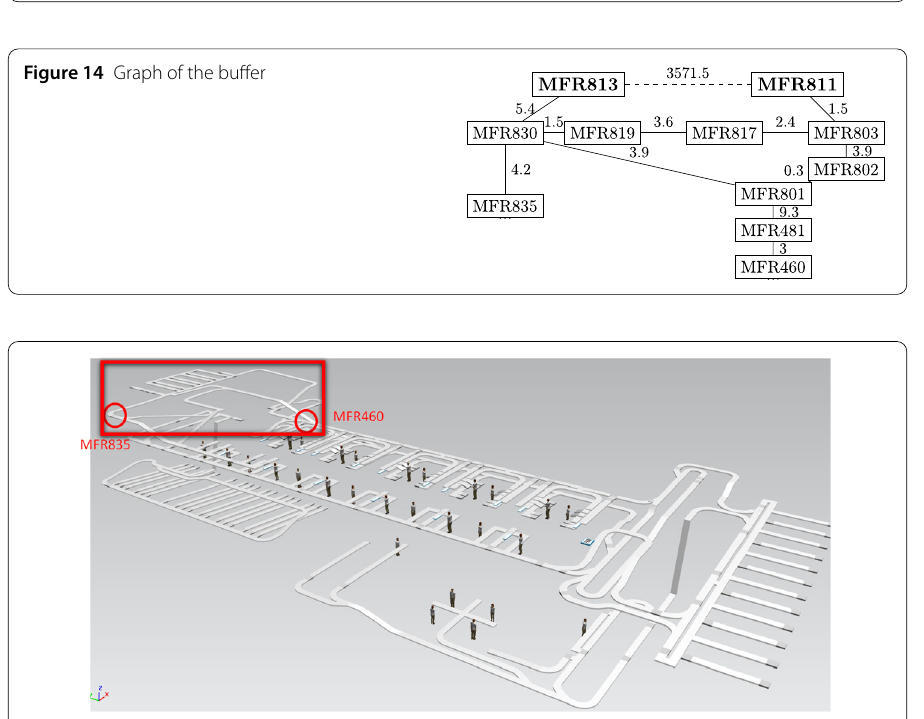
Figure 15 Original layout of the conveyor system with a marked buffer